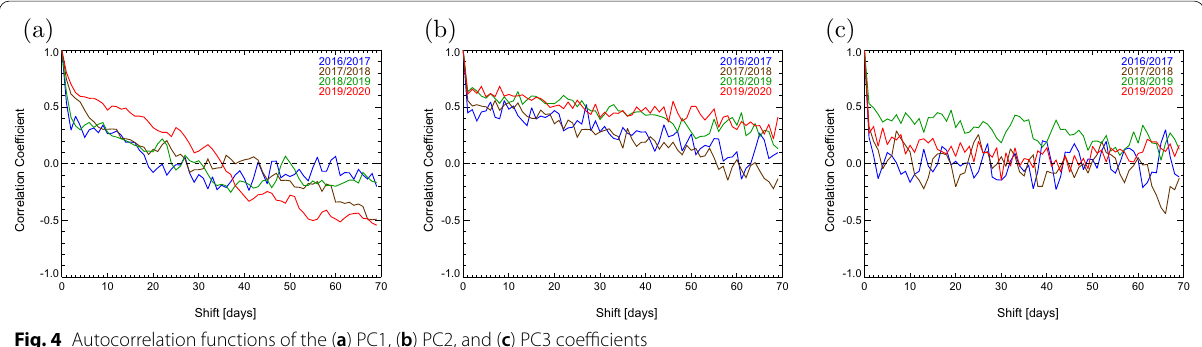
Fig. 4 Autocorrelation functions of the ( a ) PC1, ( b ) PC2, and ( c ) PC3 coefficients